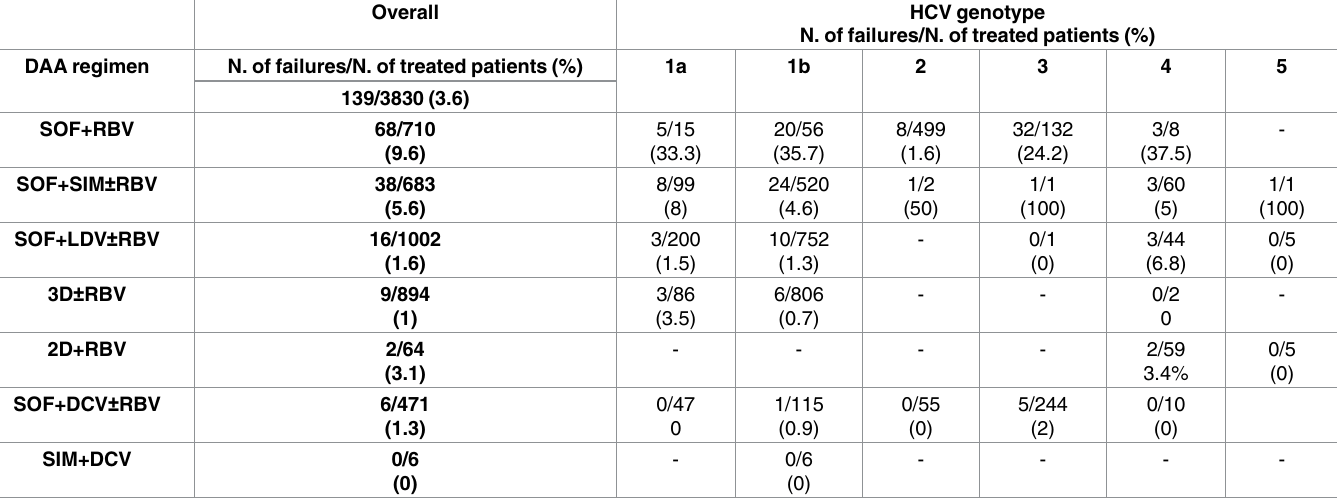
Table 3. Failure rates following the first DAA regimen, by HCV genotype and treatment regimen in patients who completed the 12 weekspost treat- ment evaluation (n = 3,830 patients).